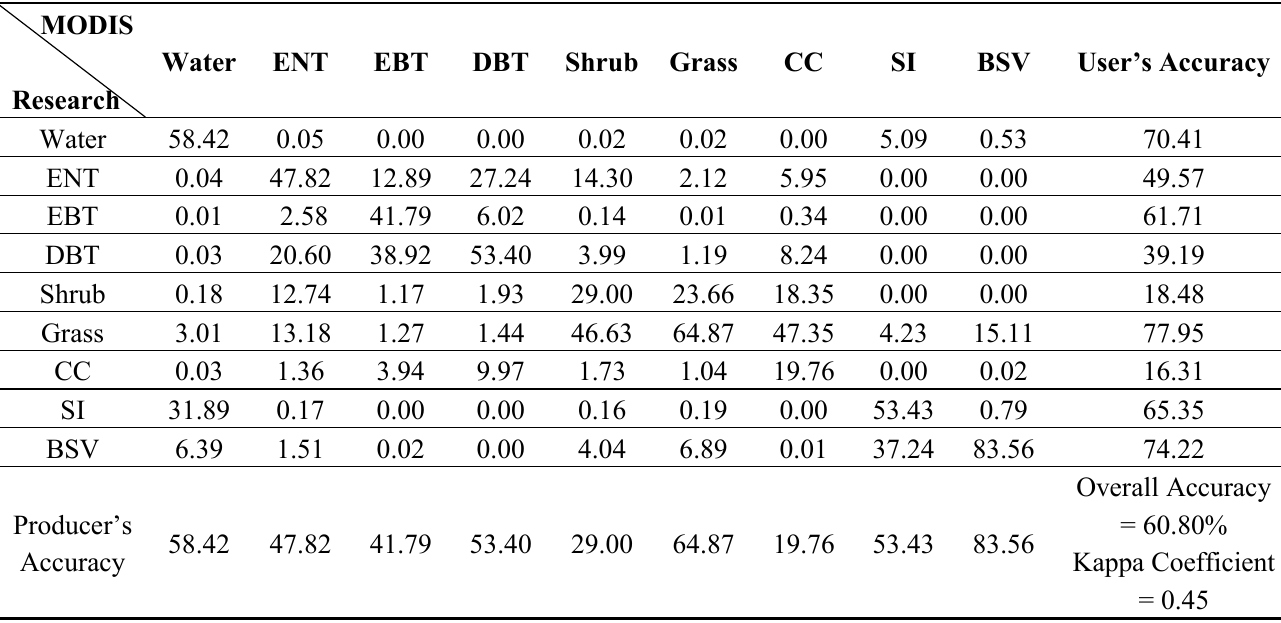
Table 3. A pixel-by-pixel comparison based on confusion Matrix between this hierarchical soft classification result and MODIS 2007 PFT products. For simplicity, vegetation types represented by initials in bracket: evergreen needle leaf trees (ENT), evergreen broad leaf trees (EBT), deciduous needle leaf trees (DNT), deciduous broad leaf trees (DBT), shrub, grass, crop (CC), snow and ice (SI), barren or sparse vegetation (BSV).